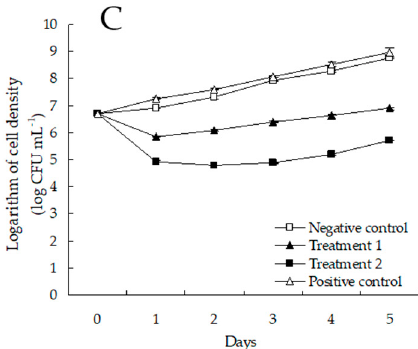
Figure 5. Antibacterial e ff ect of Bdellovibrio powder against the shrimp-pathogenic V. cholerae ( A ), V. parahaemolyticus ( B ), V. vulnificus ( C ); negative control: 0 mg L − 1 Bdellovibrio powder; treatment 1: 0.4 mg L − 1 Bdellovibrio powder; treatment 2: 0.8 mg L − 1 Bdellovibrio powder; positive control: 0.8 mg L − 1 gamma-irradiation-killed Bdellovibrio powder. Data are presented as the mean ± SD. Any di ff erences observed are considered statistically significant at p < 0.05 according to Duncan’s test.